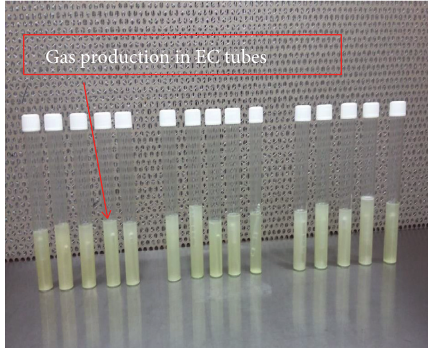
Figure 3: Growth of fecal coliform in EC broth tubes showing gas production in Durham’s tubes.